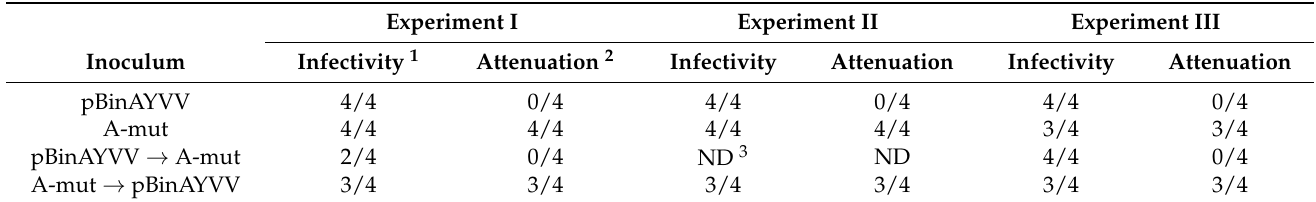
Table 3. Effect of A-mut on leaf curling symptoms caused by pBinAYVV.